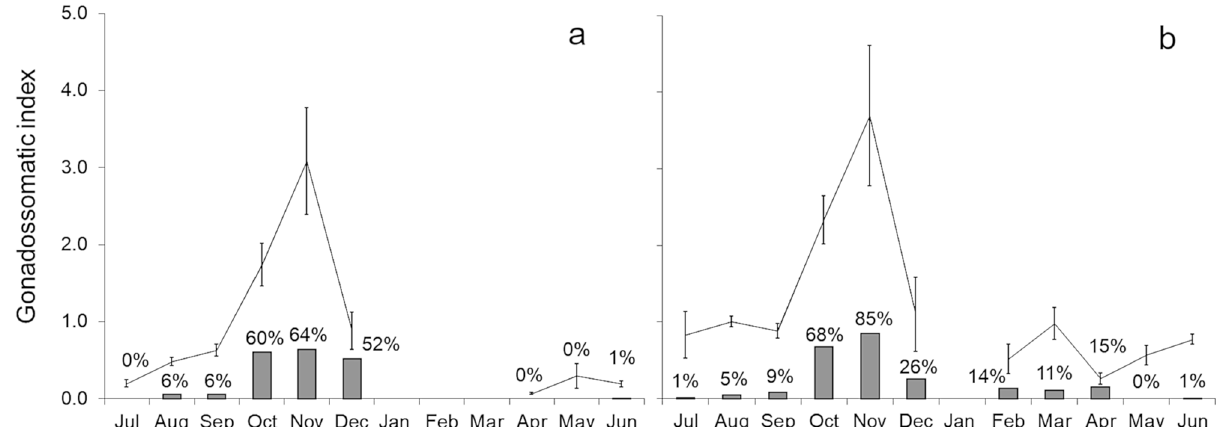
Fig. 9. Mean monthly gonadosomatic index (line) and percent of maturing and mature macroscopic stages of male (a) and female (b) Pagrus